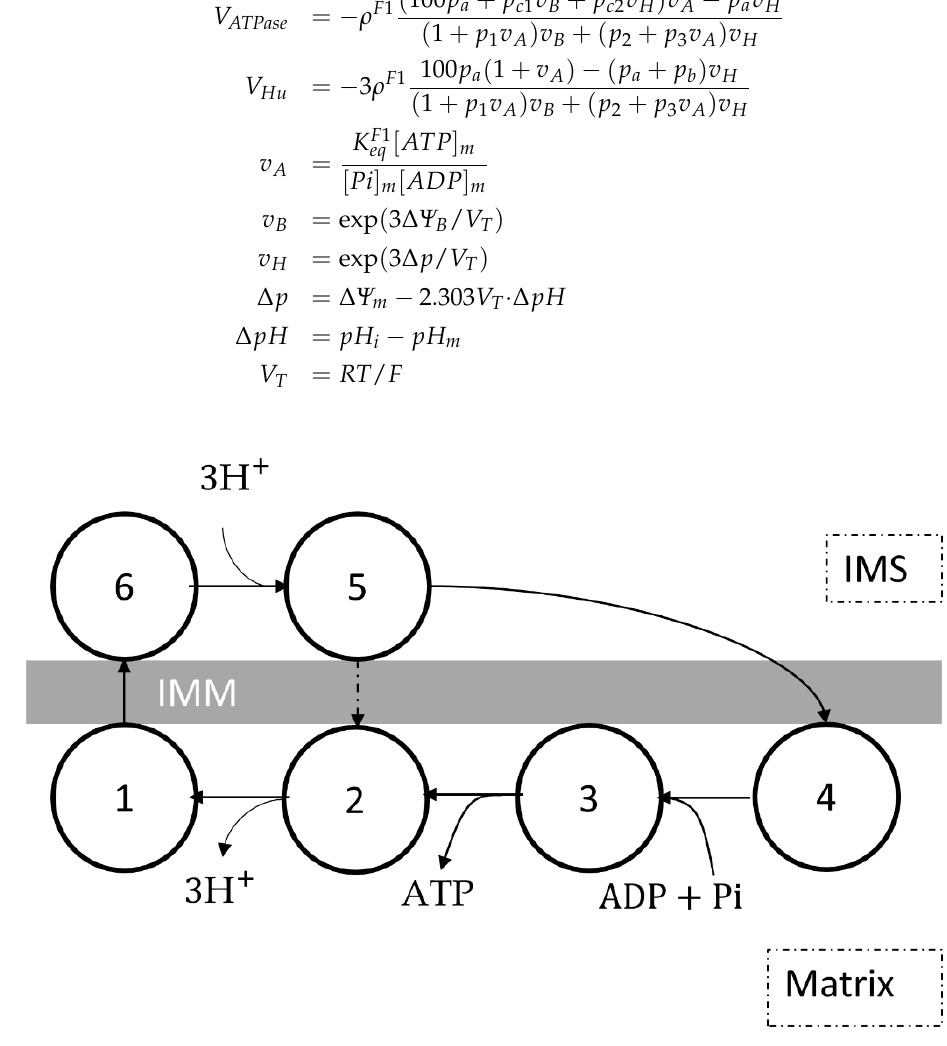
Figure 9. Schematic of the complex V model by Magnus and Keizer [54], assuming complex V is a 6-state proton pump operating in reverse. Not accounting for slip reactions (5 → 2), one ATP molecule is generated for every 3 protons translocated from the intermembrane space (IMS) to the matrix. The figure was reprinted/adapted from Magnus and Keizer [54].